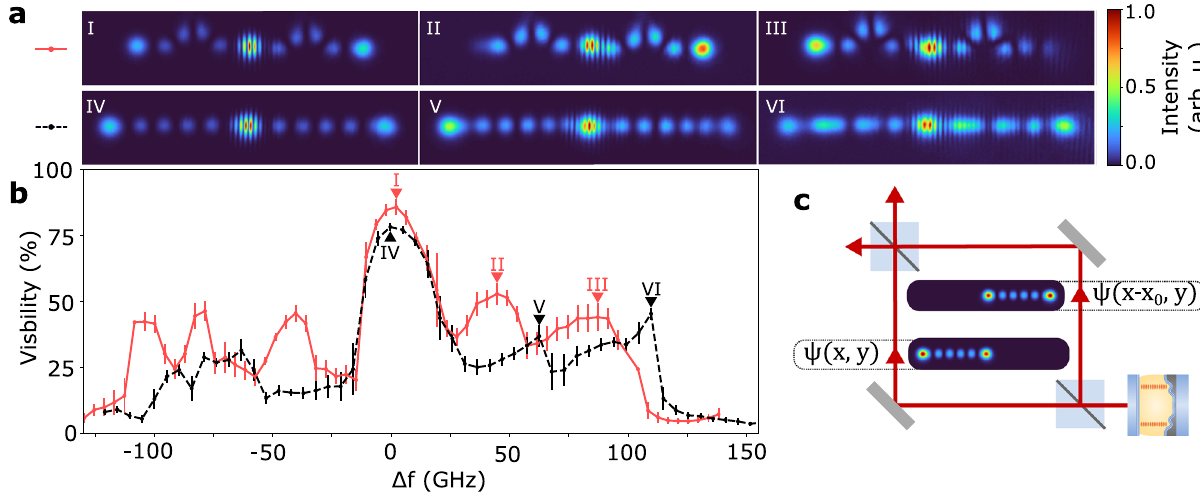
Fig. 3 Determination of the critical coupling. To determine the critical coupling, we record the fringe visibility of the interference between the two condensates as function of detuning in the natural frequencies. a Images of the interference between the coupled condensates as a function of detuning. To achieve an accurate estimate of the interferometric visibility, we take the mean of the central 5 fringes and average that over 100 pulses. Given error bars correspond to one standard deviation from the mean. b Interferometric visibility as a function of detuning between individual condensates. The Y-coupler (red solid line) and direct coupler (black dashed line) both show several breakdowns and revivals of the visibility. Data points I – III mark the maxima of these revivals for the Y-coupler and correspond to the labeled images. The same holds for data points IV-VI and the direct-coupler curve. c Schematic representation of the Mach-Zehnder interferometer used for superposing the condensates and creating the interference